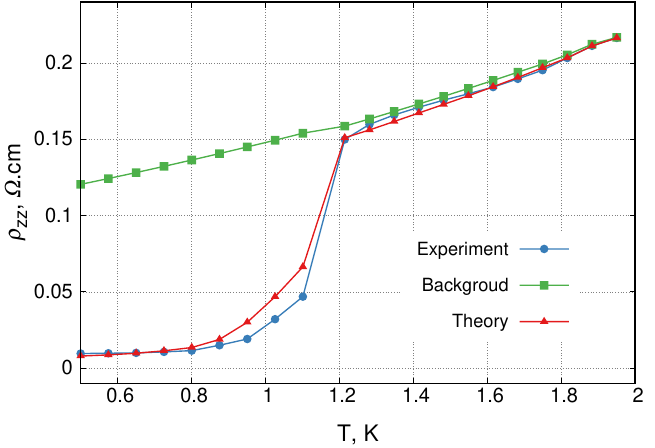
Figure 3. Temperature dependence of resistivity along z -axis. Experimental values (blue circles) are taken for sample #4 from Figure 2b of Ref. [6]. Background-phase metallic resistivity (green squares) is found by second-order approximation, i.e., ρ b zz = 8.17 + 4.2 T + 1.4 T 2 Ω · cm. Theoretical values (red triangles) are found from z -axis resistivity in Equation